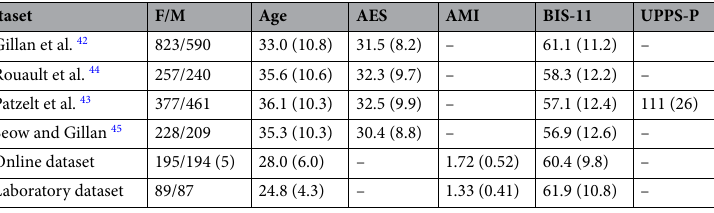
Table 1. Demographics characteristics. The table shows the number of females (F) and males (M) included in each study (“Prefer not to say” in parenthesis). Group mean total scores (standard deviation in parenthesis) are shown for each questionnaire included in a